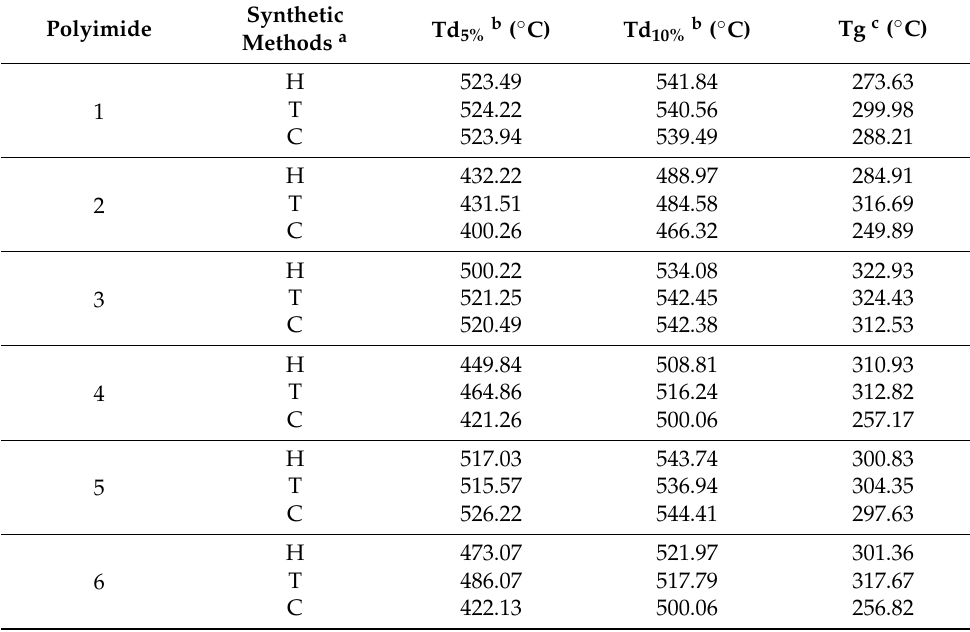
Table 3. Thermal properties of synthesized